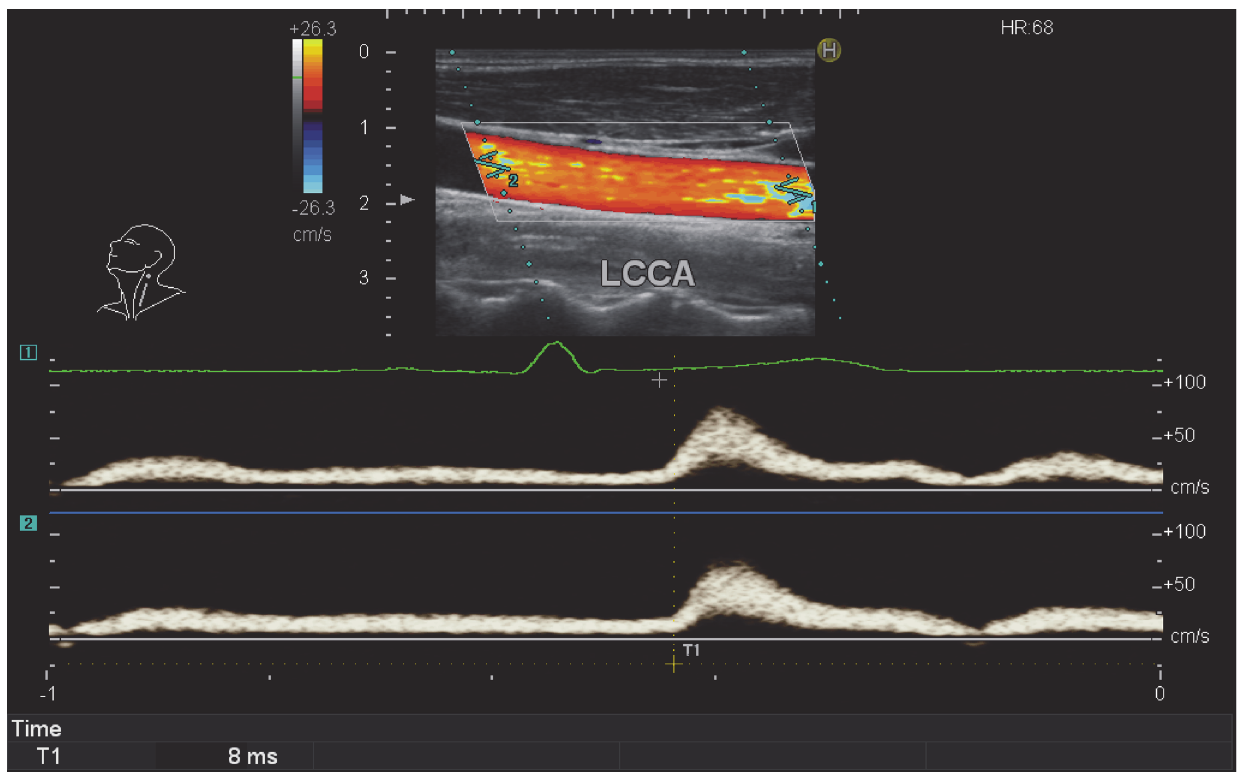
Fig 4. A representative local PWV measurement in a healthy subject. In the upper part, the two dimensional echography showed the upstream sample volume 1 and downstream sample volume 2 and their exact distance could be measured. The Doppler simultaneous velocity spectra were shown at the lower part. The transit time between these two sites was measured (8ms). LCCA, left common carotid artery; PWV, pulse wave